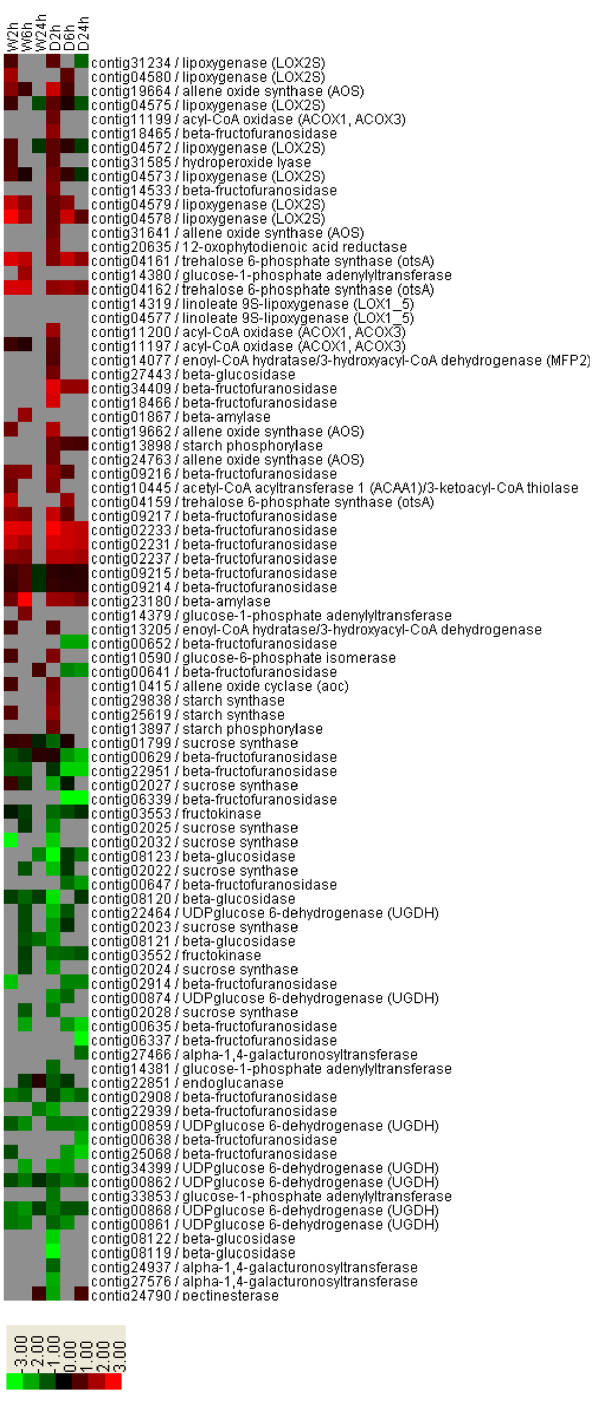
alanine metabolism. Most ribosomal genes were down-regulated after defoliation at 2 h, but some were up-regulated at 24 h (Figure 4A). The expression levels of the genes involved in